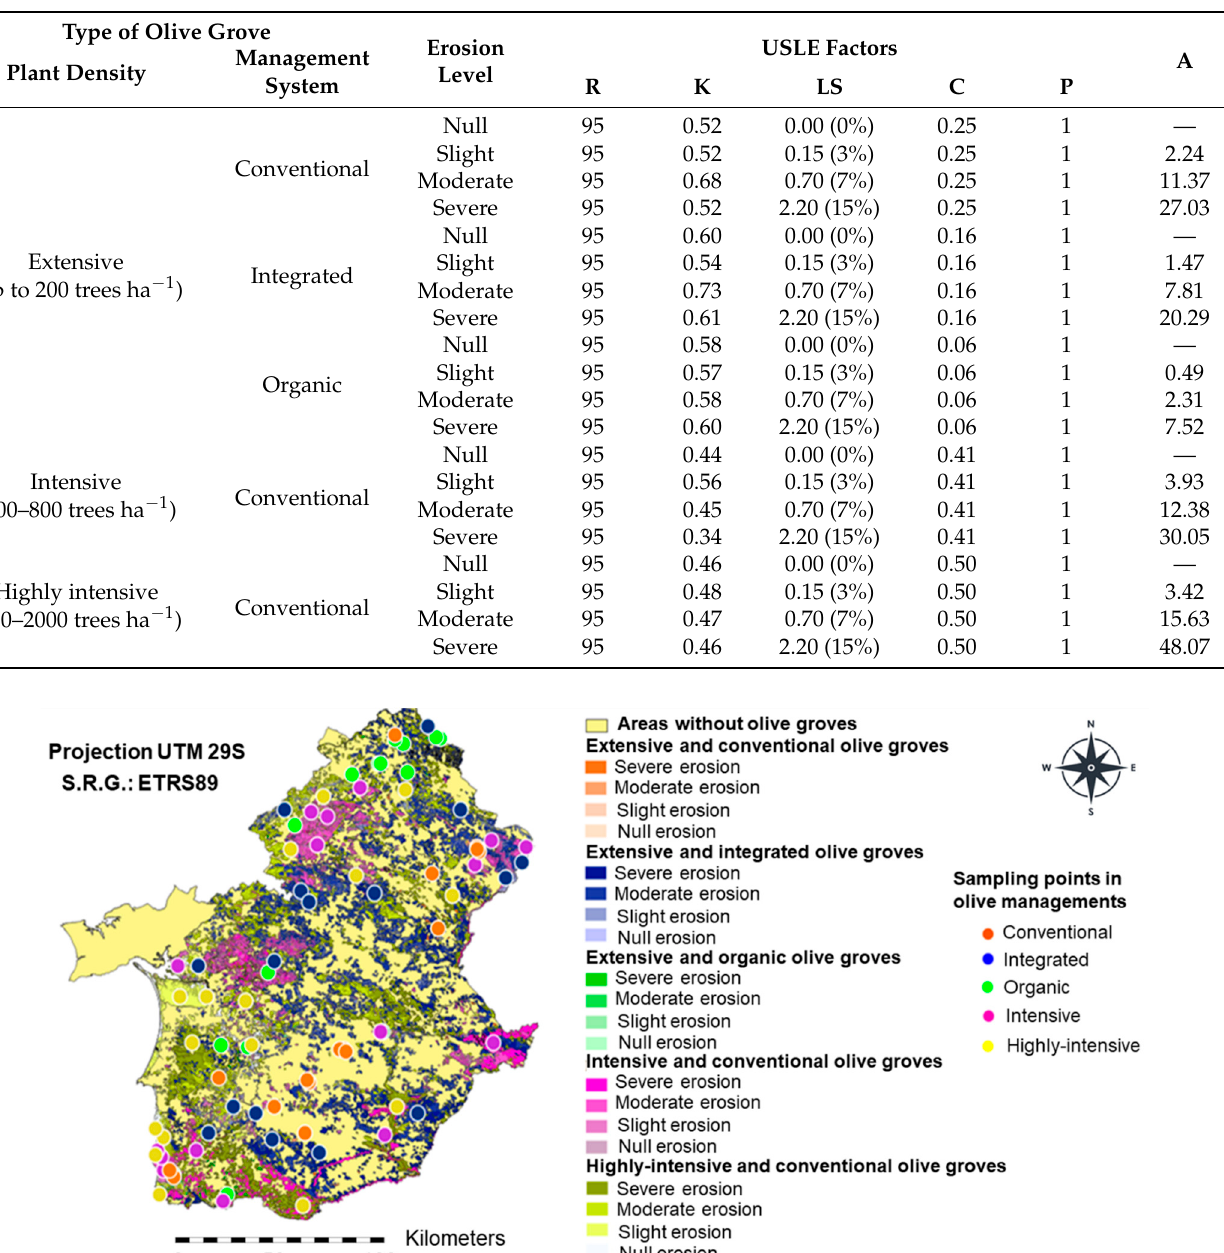
Table 1. Erosion estimation (A, t ha − 1 year − 1 ) for each type of olive grove sampled, specifying